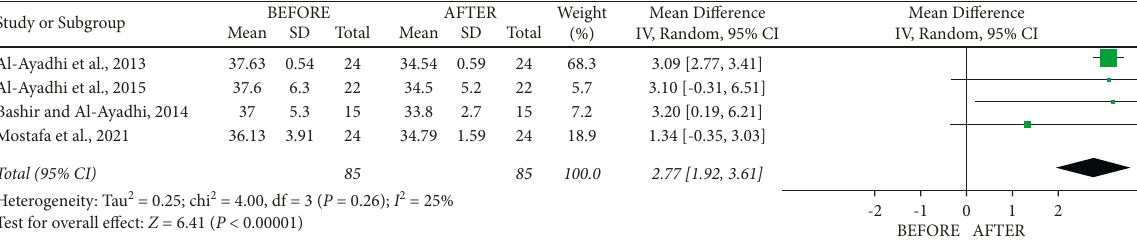
Figure 3: Forest plot of the meta-analysis results showing the effects of treatment on ASD patients consuming raw camel milk. Study or Subgroup